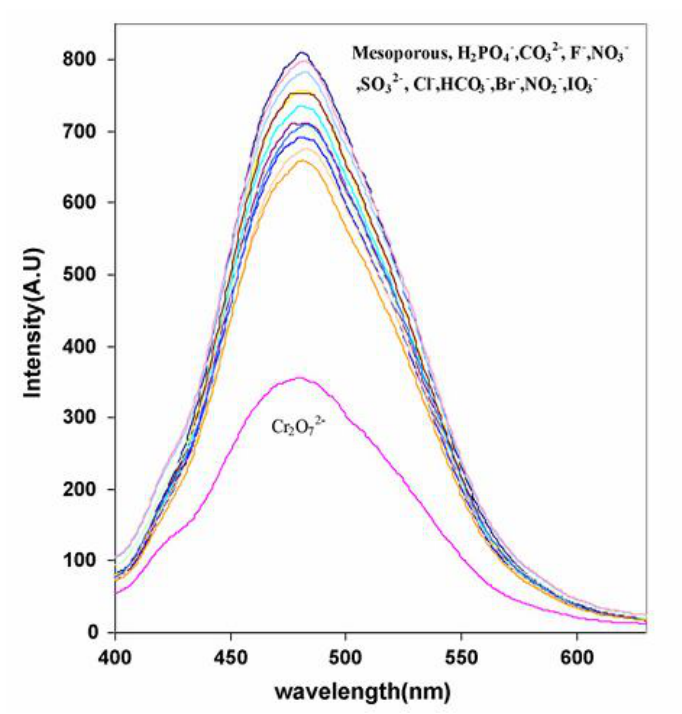
Fig. 5. Fluorescence response of SBA-SPS-AlQ